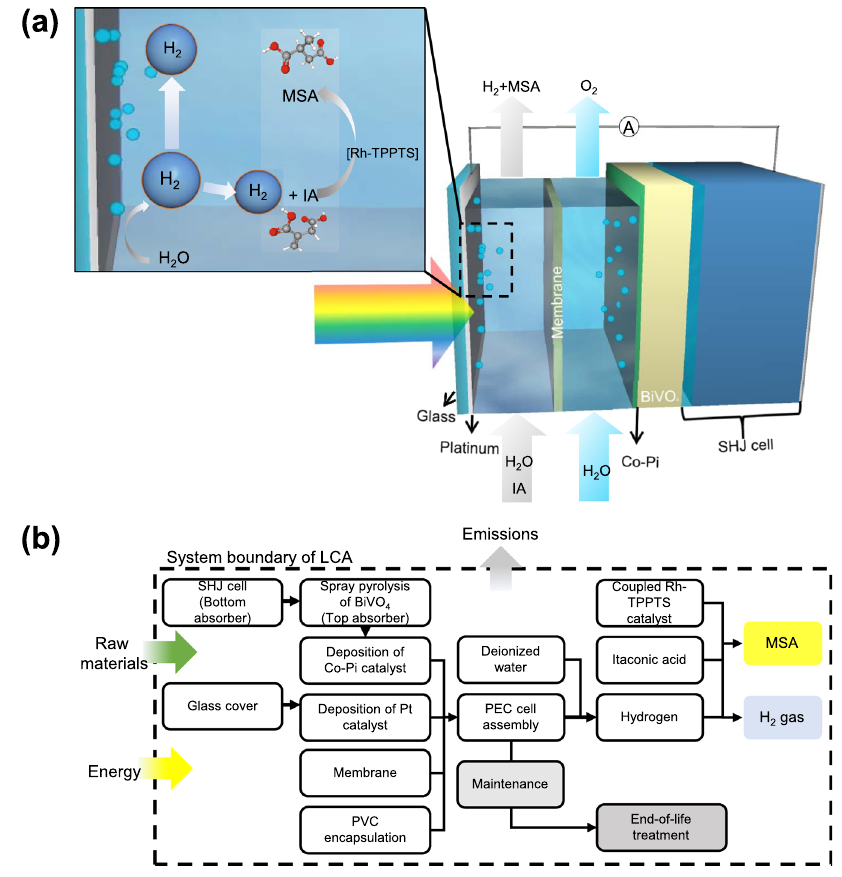
fl ow diagram of the coupled PEC device for hydrogen production and hydro- genation of IA to MSA, starting from raw material extraction to the end-of-life treatment. The dashed line indicates the cradle-to-gate system